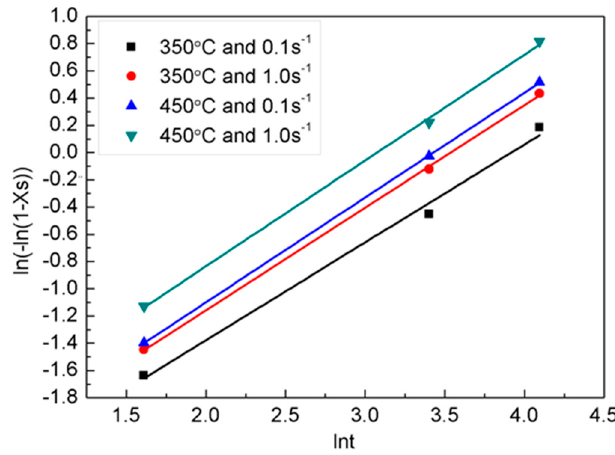
Figure 5. The relationship between ln ( − ln ( 1 − X s )) and ln t